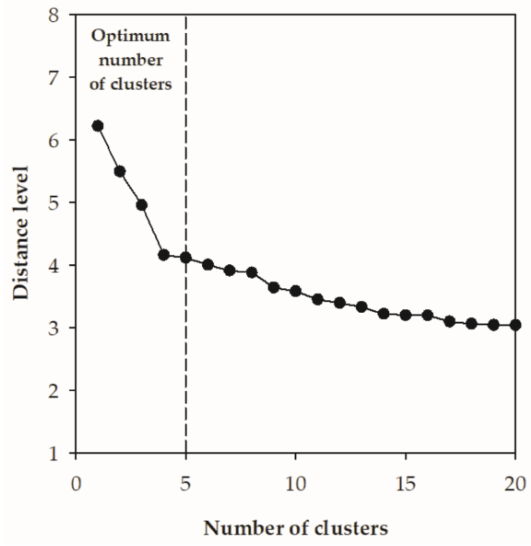
Figure 11. Dependence of distance level on the number of clusters as basis for elbow method of optimal cluster number to be used for the characteristic of paddy farming.